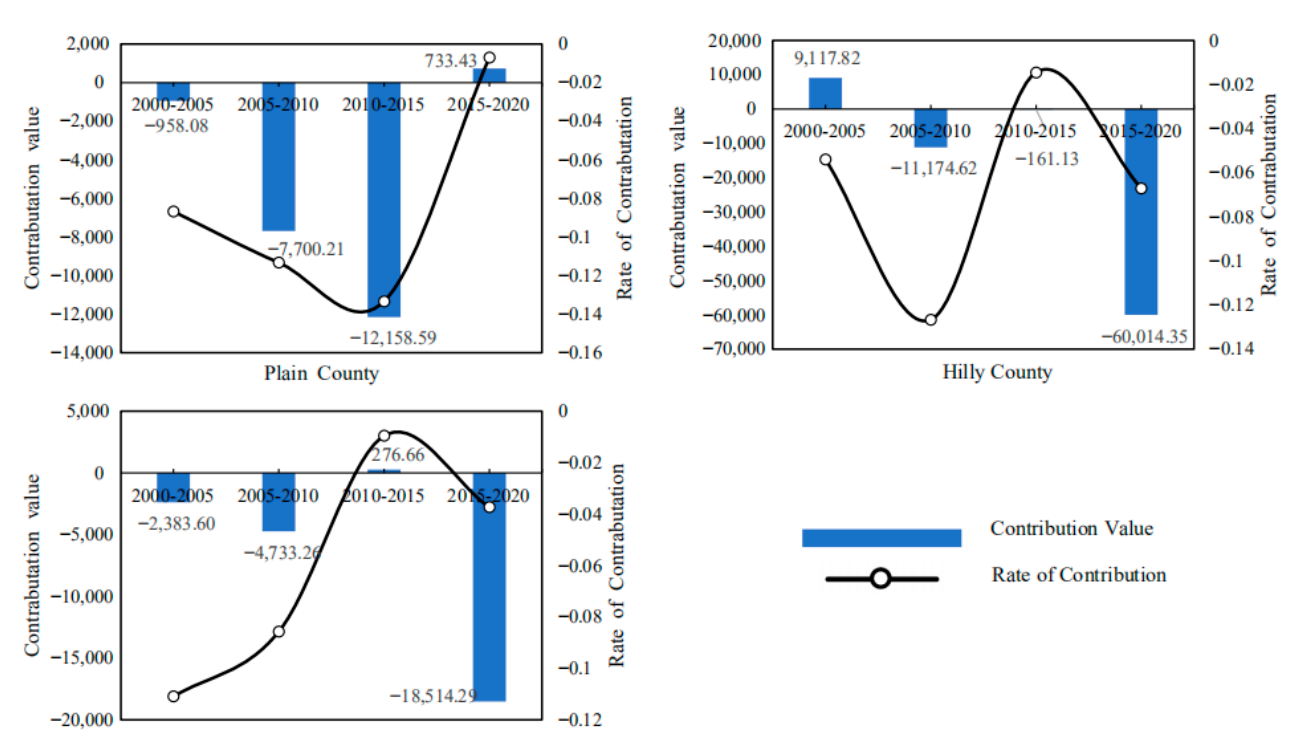
Figure 13. Topographic heterogeneity of agricultural output level increase and emission effect (including Plain County, Hilly County, Mountain County).